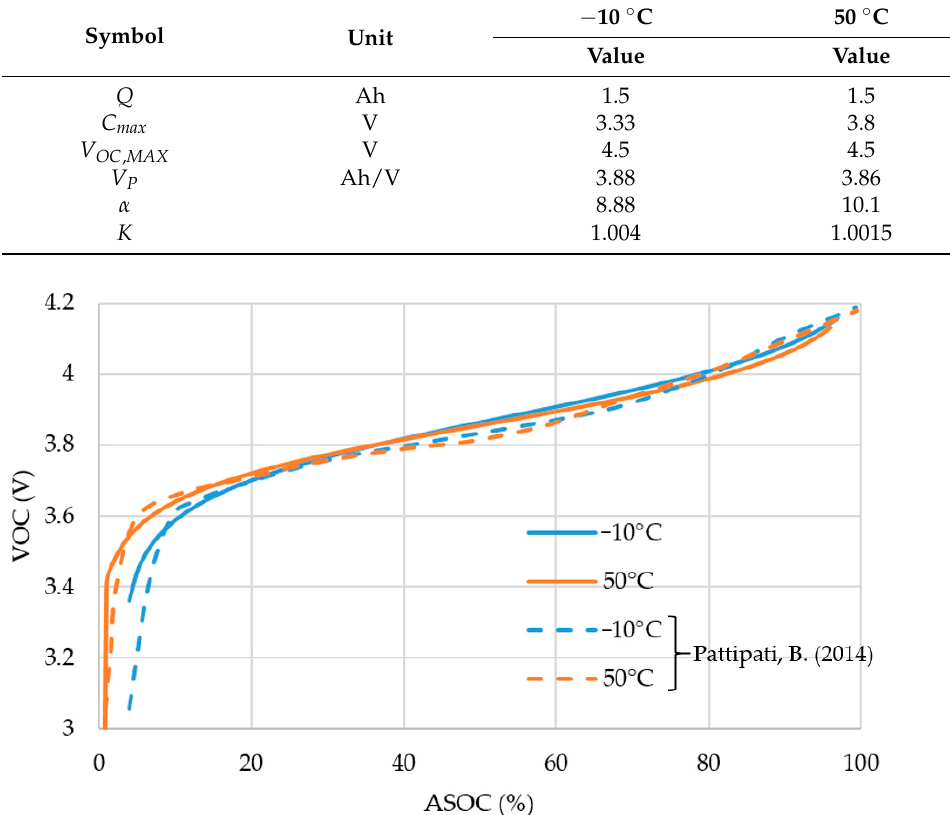
Figure 14. Proposed model fitting under different operating temperatures [21]. Table 5. Parameters under different operating